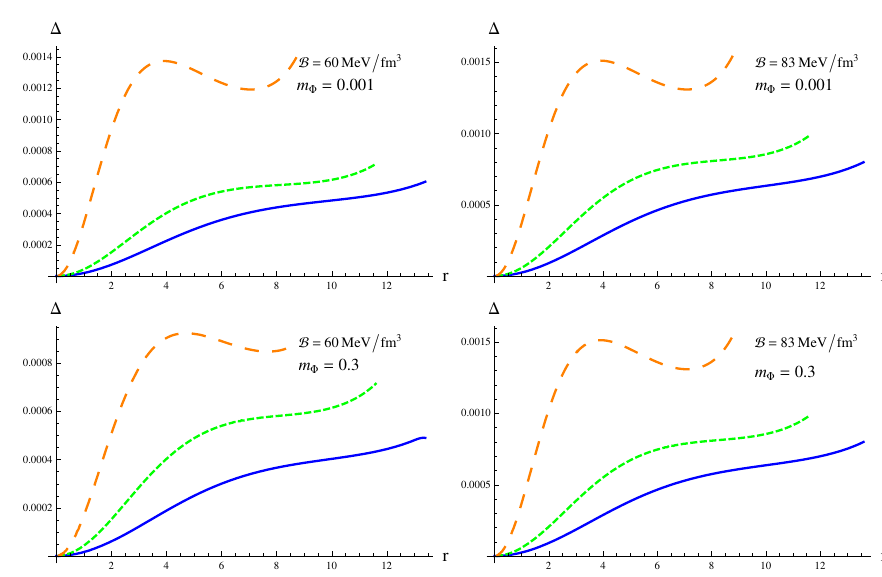
Figure 4. Effective anisotropy (in km − 2 ) as a function of r (in km).